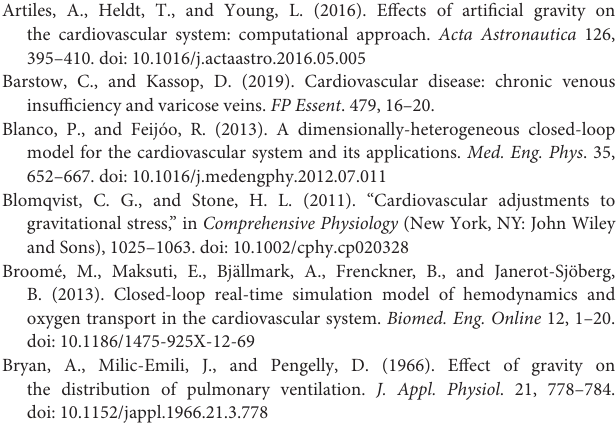
table test in autonomic medicine. Clin. Autonomic Res . 29, 215–230. doi: